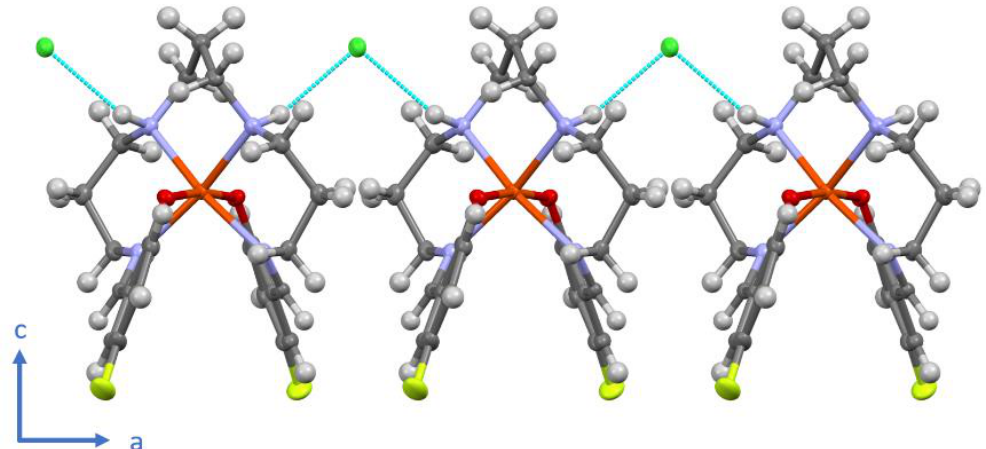
Figure 4. View of 1-D hydrogen bonding chain between adjacent complexes, mediated by chloride counterions in [Fe(5F-sal 2 333)]Cl, 1 .